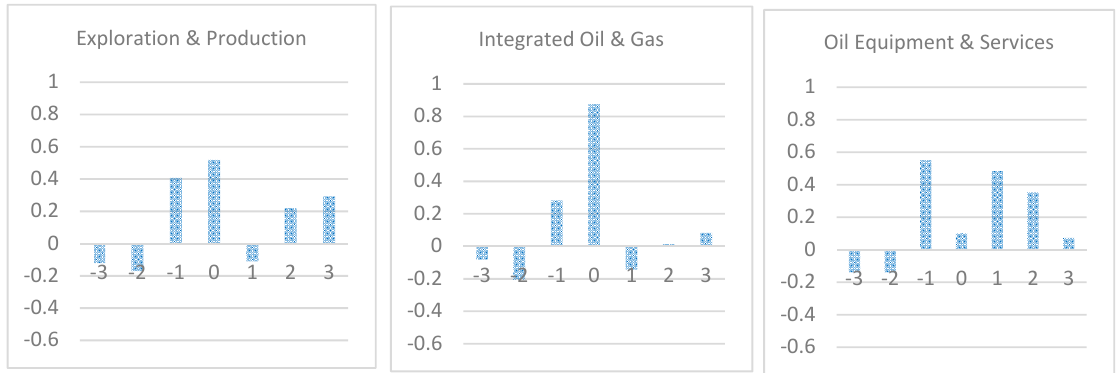
Figure 5. Cross correlograms for leads and lags of Oil and Gas subsector cash